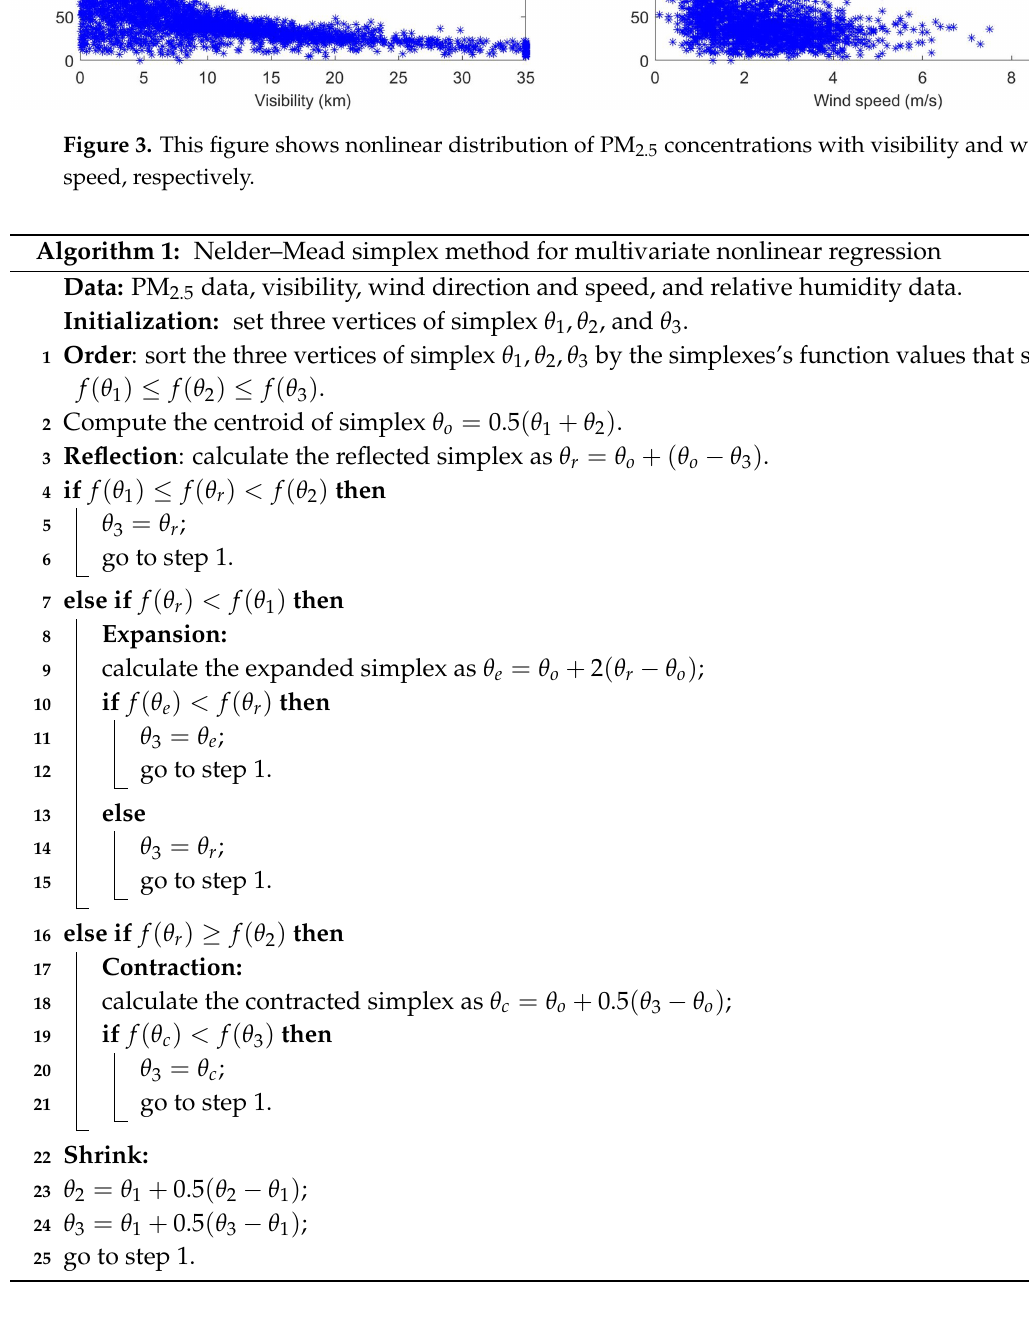
Data: PM 2.5 data, visibility, wind direction and speed, and relative humidity